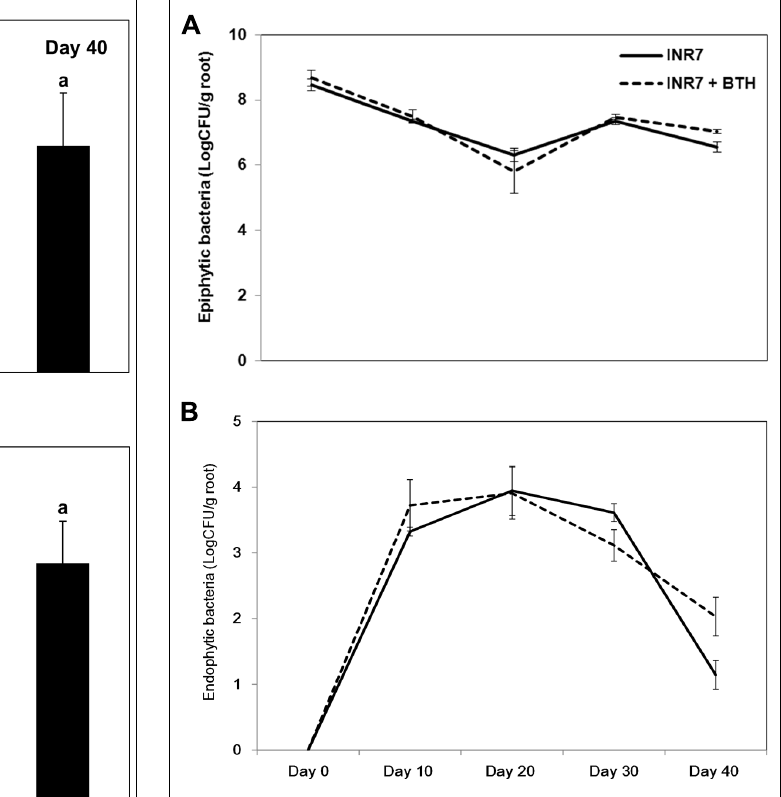
FIGURE 5 | Effects of BTH on bacterial populations in the pepper rhizosphere. (A) Epiphytic population dynamics of B. pumilus INR7 with and without 0.5 mM BTH treatment, (B) Endophytic population dynamics of B. pumilus INR7 with and without 0.5 mM BTH treatment. Bacterial populations of spontaneous rifampicin resistant B. pumilus INR7 were quantified at the day of application on pepper roots and 0, 10, 20, 30, and 40 days after the application. Bars represent mean ±